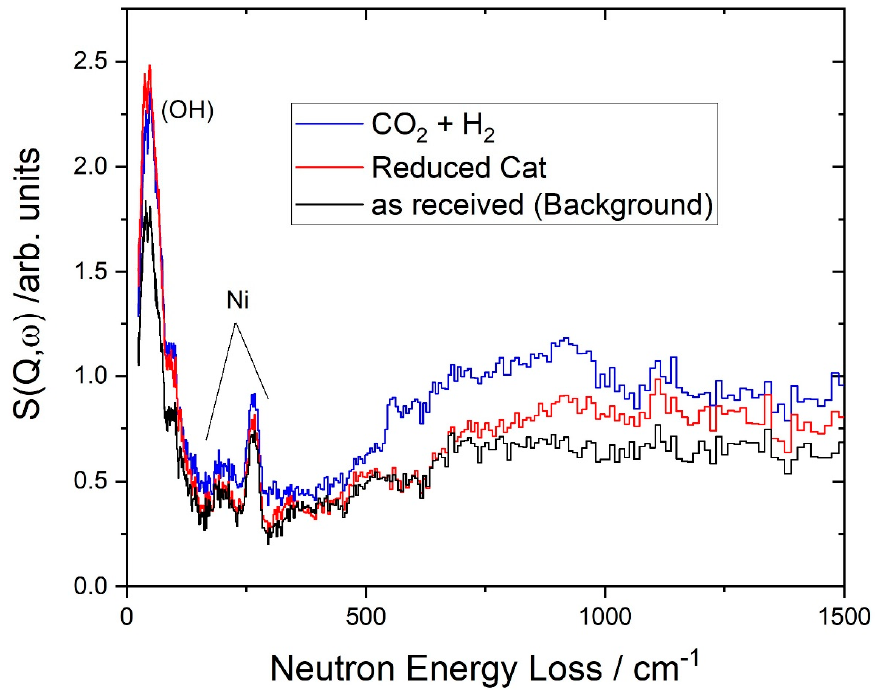
Figure 5. INS spectra as derived by subtracting from the measured spectrum that of the empty sample holder: Ni on alumina/silica as received, after reduction and after methanation (see also Figure 2).